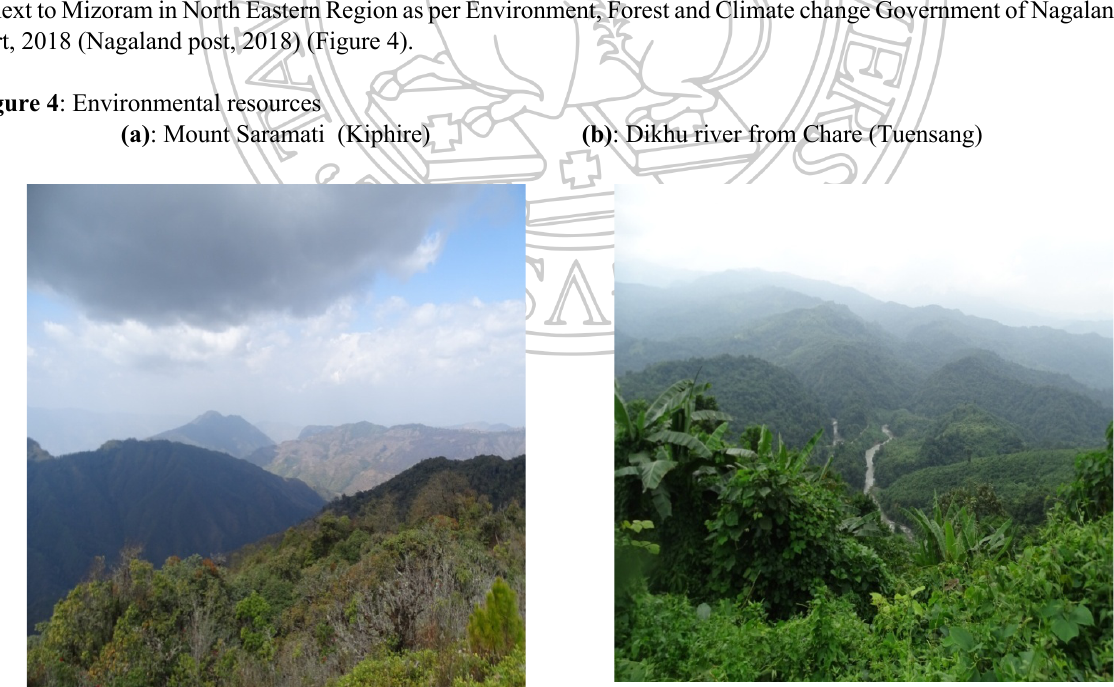
Figure 4 : Environmental resources (a) : Mount Saramati (Kiphire) (b) : Dikhu river from Chare